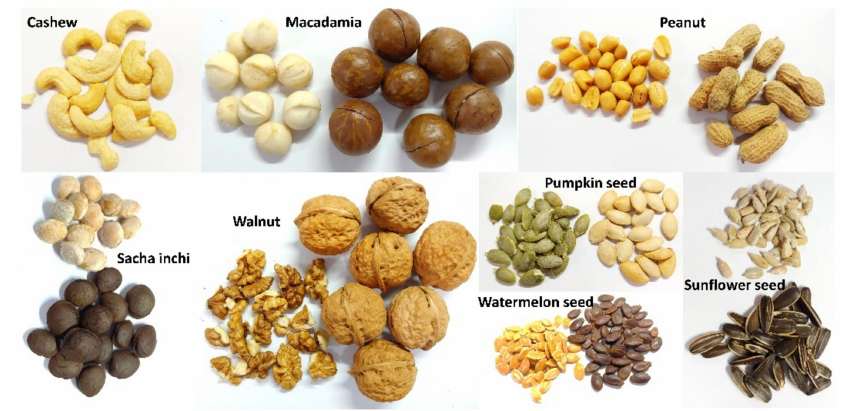
Figure 1. The commonly consumed nuts and seeds examined in the